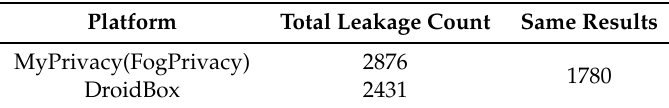
Table 3. Accuracy